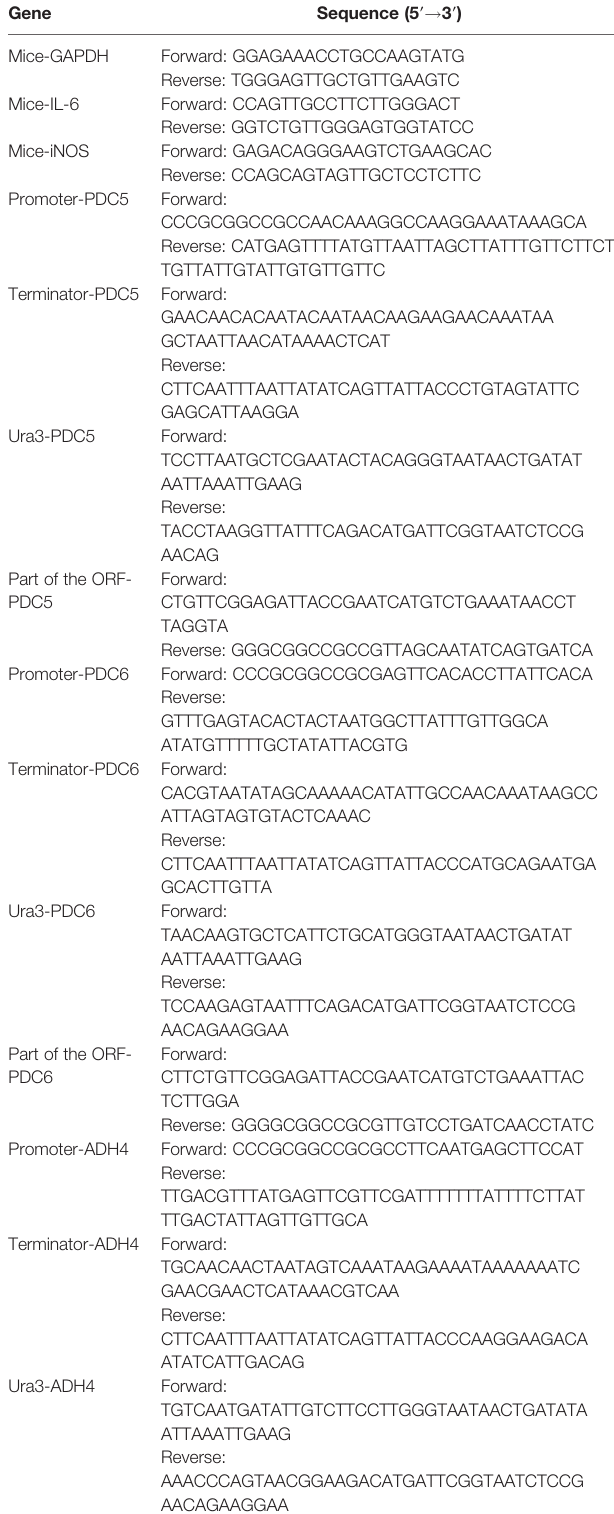
TABLE 1 | Primers used in this study. Gene Sequence (5 ′ ! 3 ′